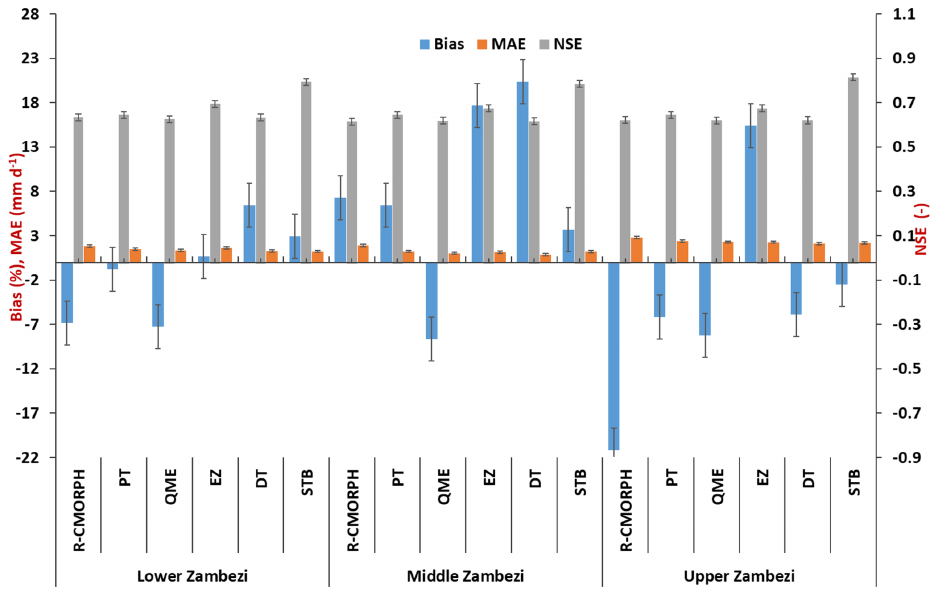
Figure 5. Percentage bias, mean absolute error (left axis), and Nash–Sutcliffe efficiency (NSE) (right axis) of corrected and uncorrected CMORPH (R-CMORPH) daily rainfall averaged for the Lower Zambezi, Middle Zambezi, and Upper Zambezi for the 1999–2013